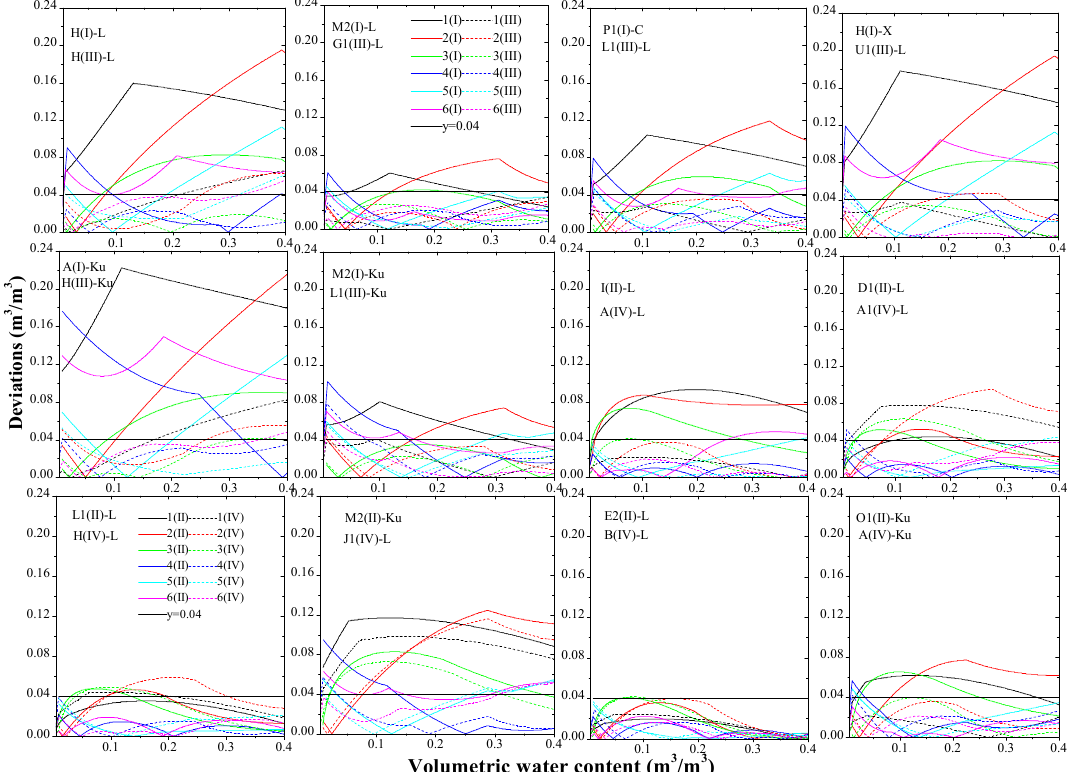
Figure 6. Deviations in the soil moisture estimates by different models for typical soil samples. The numbers (from ‘1 ′ to ‘6 ′ ) were explained earlier in Section 2. The black straight line represents the soil moisture estimate accuracy requirement of 0.04 m 3 /m 3 .